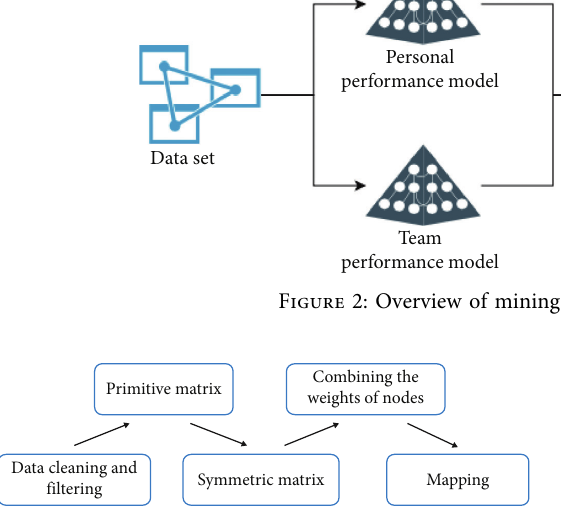
Figure 3: Overview of mining strategy for football social network. Table 1: The information of Match 6.